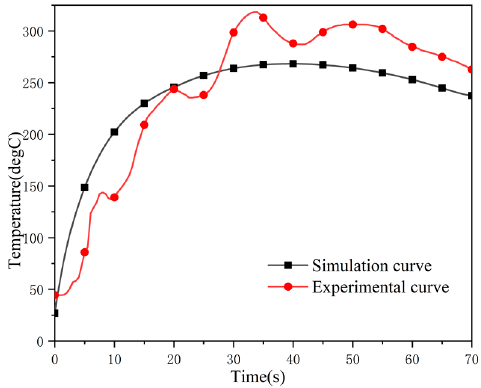
Figure 6. Comparison of experimental and simulation results.